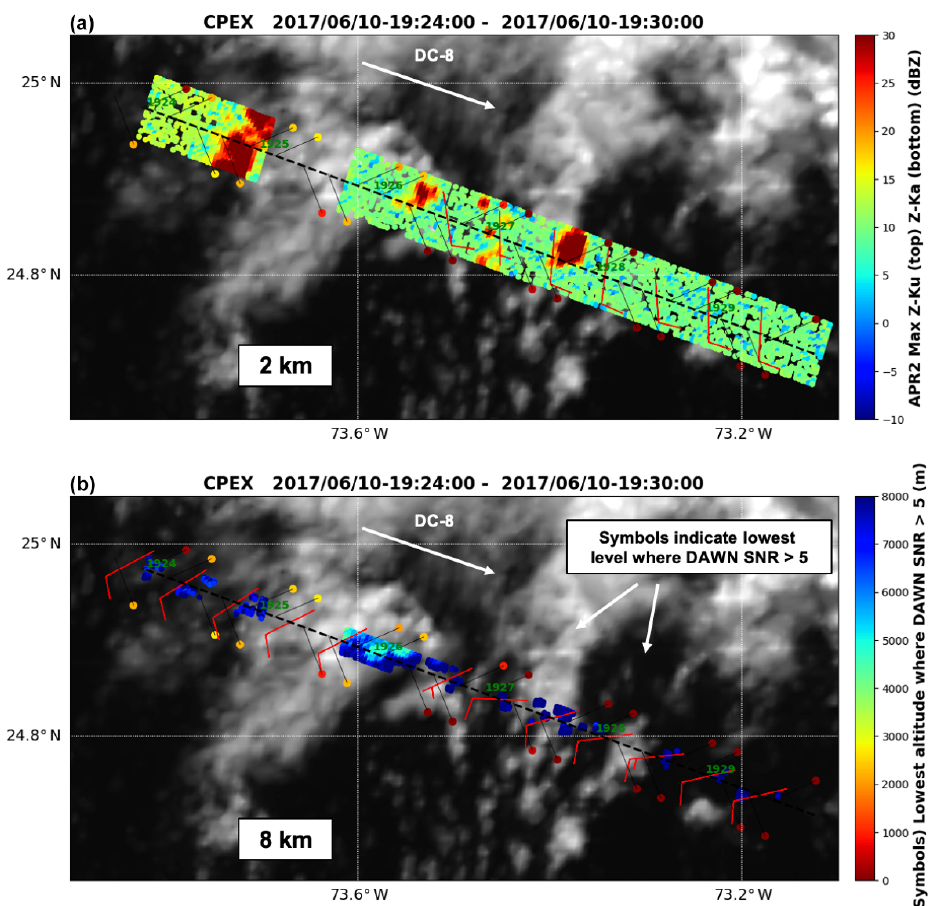
Figure 6. Same as Fig. 5, but zoomed in on the flight segment between 19:24 and 19:30UTC (Box 2 in Fig. 4).